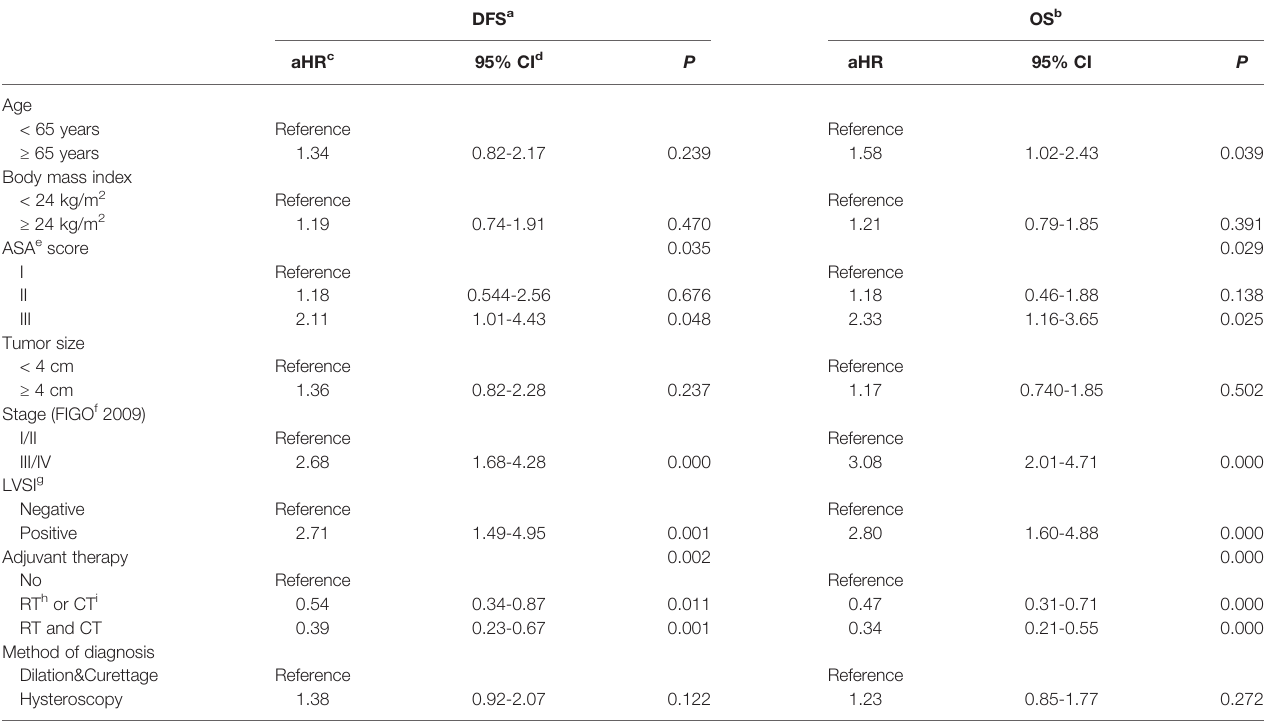
TABLE 3 | Multivariate analysis of prognosis for women with apparent early-stage type II endometrial